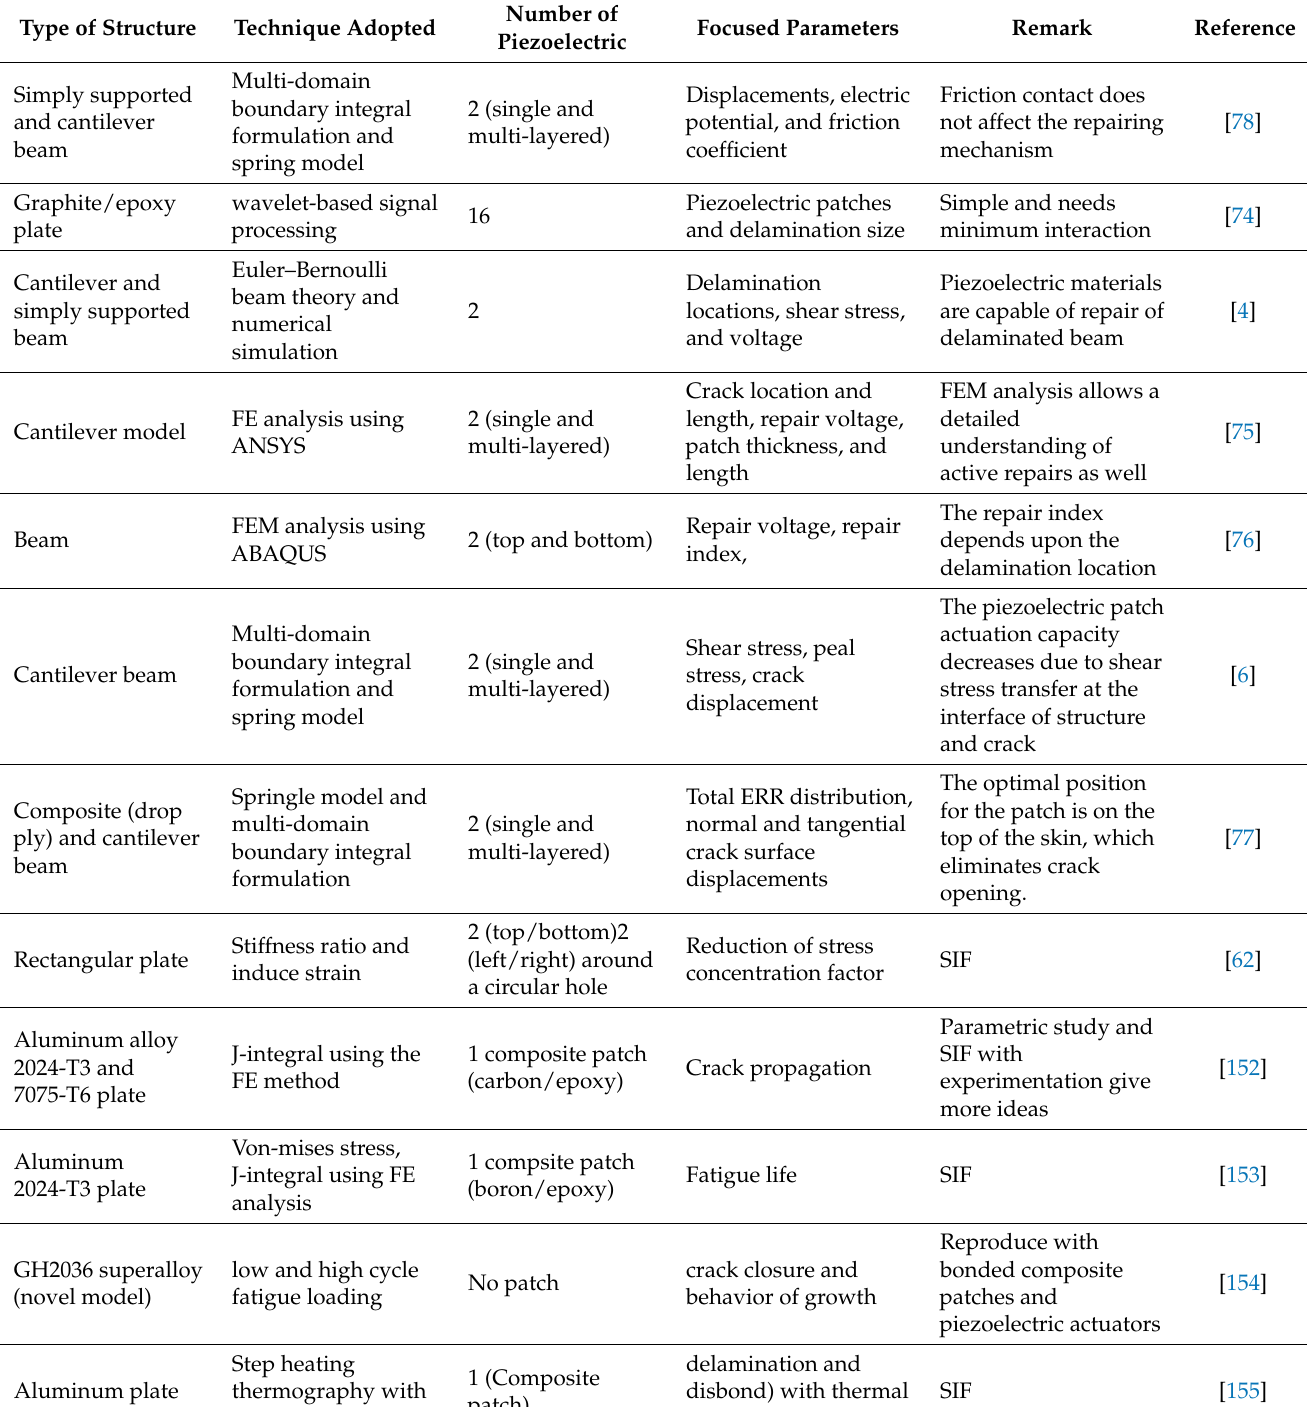
Table 1. Summary of previous work based on the structural